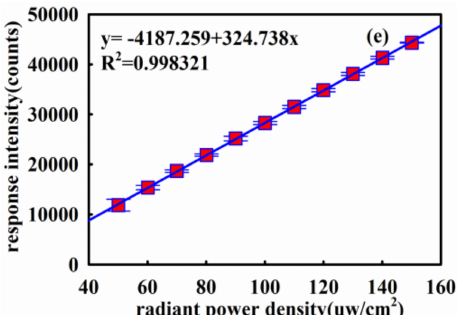
Figure 10. The measured relationship between the UV stimulation and response of the UVOFS based on the materials ( a ) CsI:Tl, ( b ) Gd 2 O 2 S:Tb, ( c ) Gd 2 O 2 S:Pr, ( d ) La 2 O 2 S:Tb, ( e ) La 2 O 2 S:Eu.